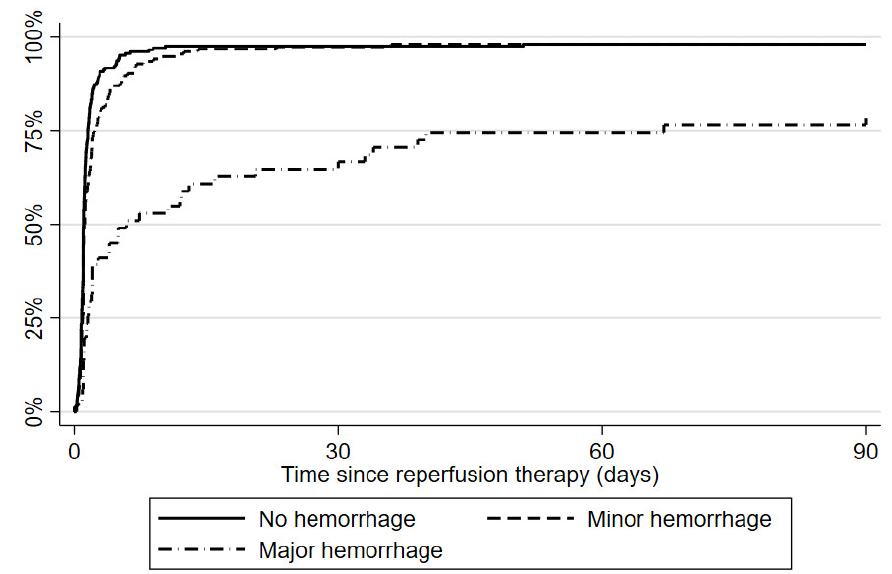
Figure 1. Proportion of patients starting secondary prevention over 3 months.